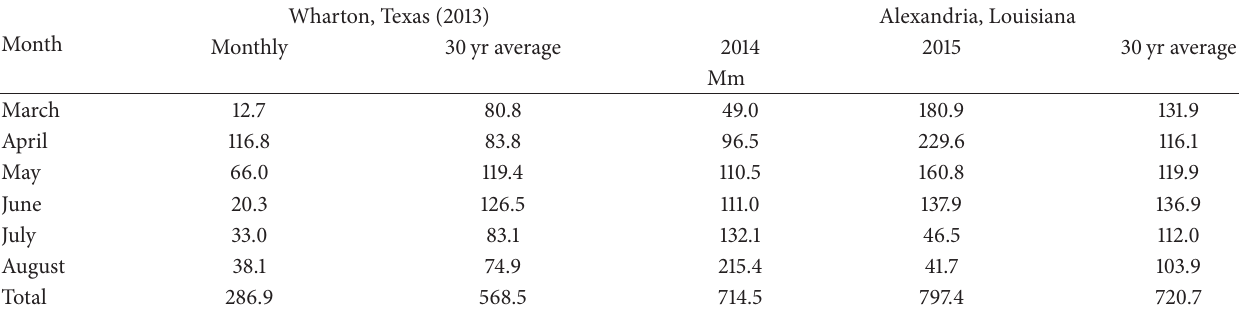
Table 1: Rainfall amounts during the 2013 through 2015 growing season at each test